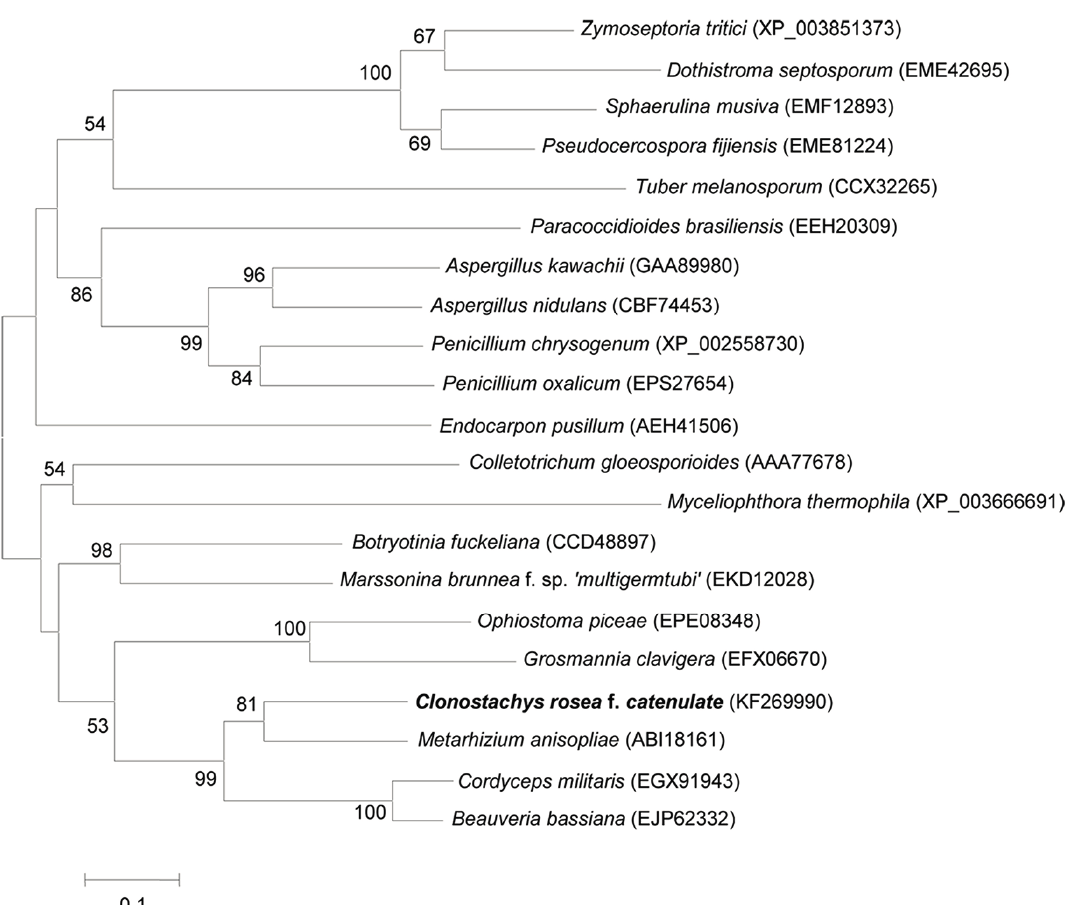
Figure 2. Neighbor-joining tree of protein Per3 from C. rosea f. catenulata HL-1-1 constructed using MEGA 5.1. Numbers in parentheses represent accession numbers in the NCBI sequence database. Numbers at the nodes indicate the bootstrap values on neighbor-joining analysis of 1000 bootstraps. Bars (=0.1) represent sequence